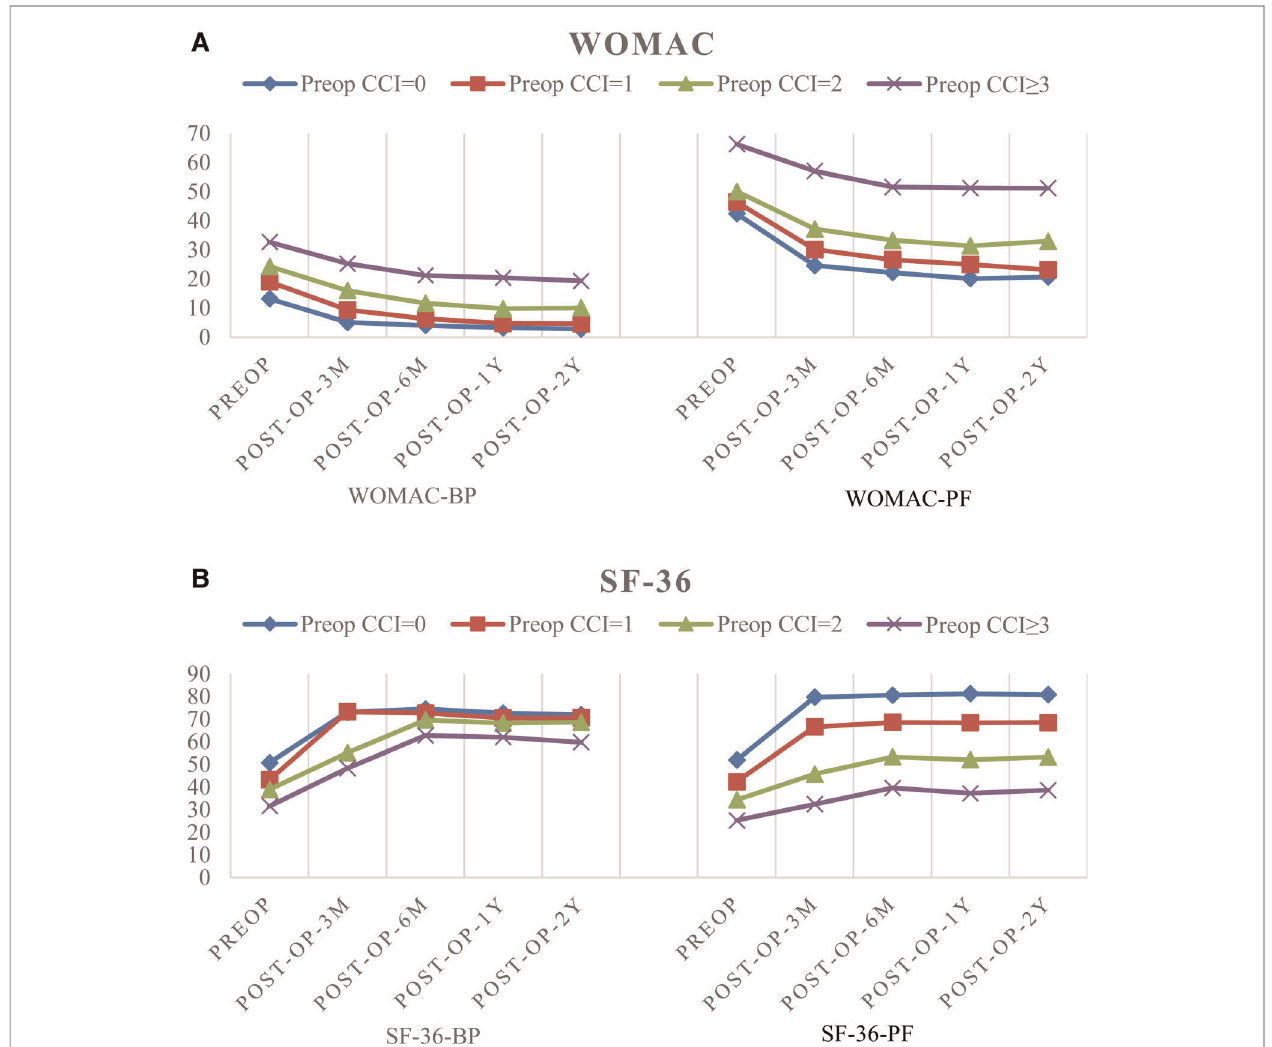
FIGURE 1 | ( A ) The trend of changes in pain and functional scores based on WOMAC. ( B ) The trend of changes in pain and functional scores based on SF-36.